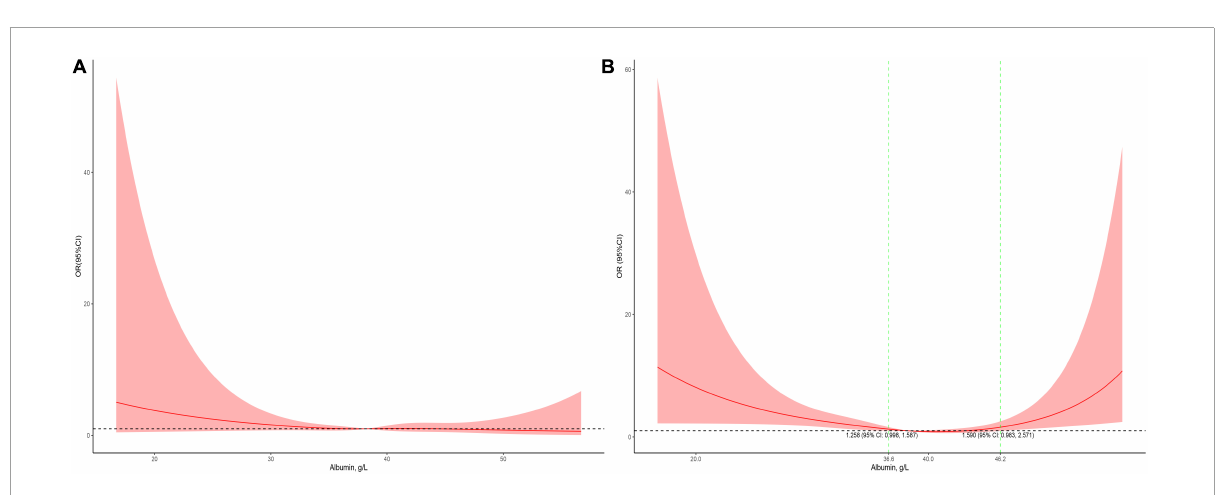
FIGURE5 Stratified analysis for the association between serum albumin levels and mortality in surgical patients ( A, subgroup analysis in cardiac surgery patients; B, subgroup analysis in non-cardiac surgery patients). The models were adjusted for age, race, sex, admission form emergency department, PO 2 , PCO 2 , shock index, RR, bilirubin, eGFR, mechanical ventilation, inotropes, AKI, and